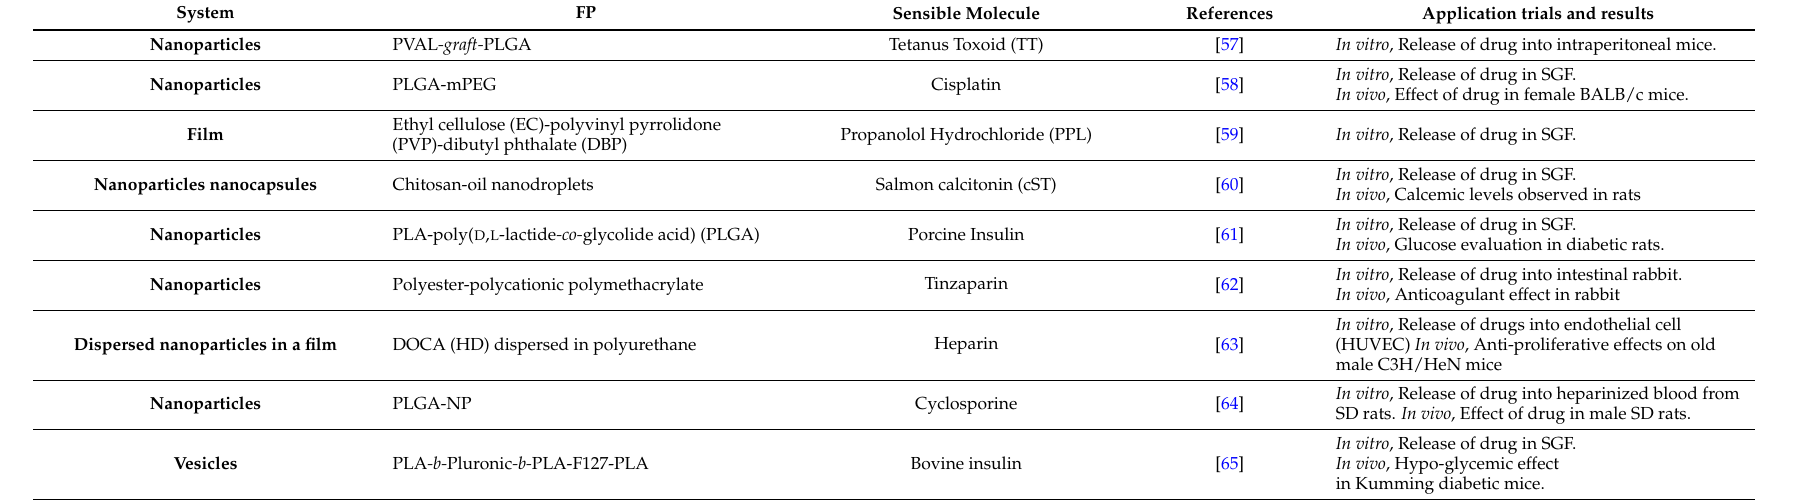
Table 3. FP systems with absorption and delivery enhancement of sensitive